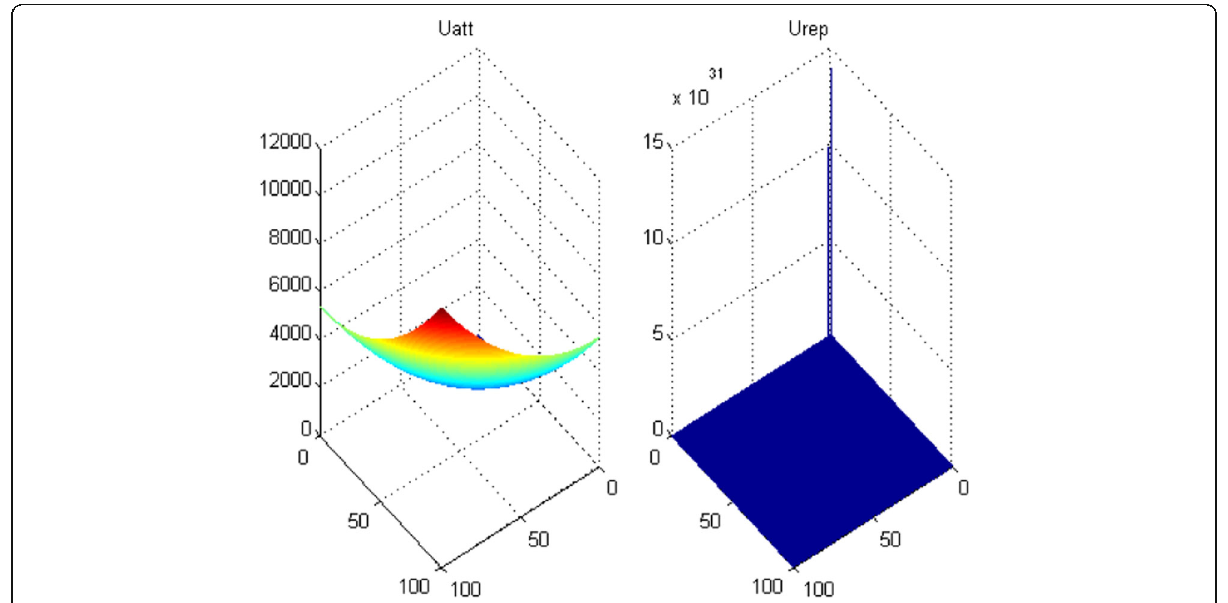
Fig. 22 Mesh plot of the potential energy of attraction and repulsion in the modified artificial potential field algorithm for the curve-shaped